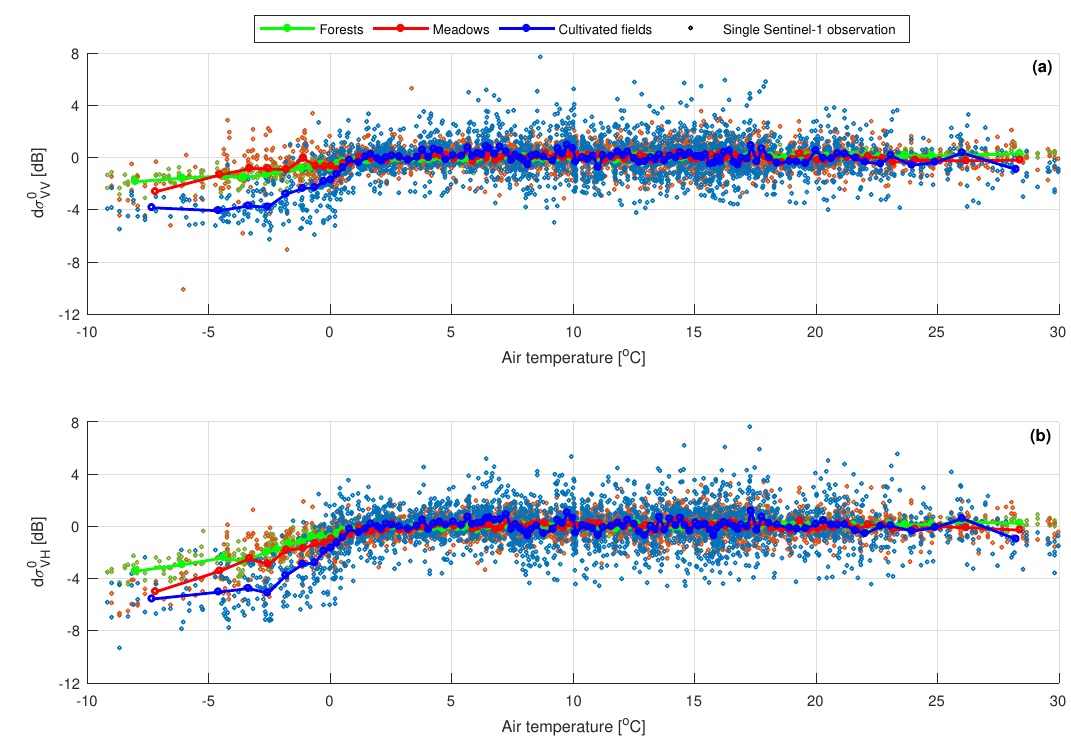
Figure 5. The effect of air temperature on the seasonal anomalies ( d σ 0 ) of the Sentinel-1 σ 0 observations in VV polarization ( a ) and VH polarization ( b ). Each point on the lines represents a bin of 25 Sentinel-1 observations along the x-axis. The Sentinel-1 observations masked for snow or rain interception are not